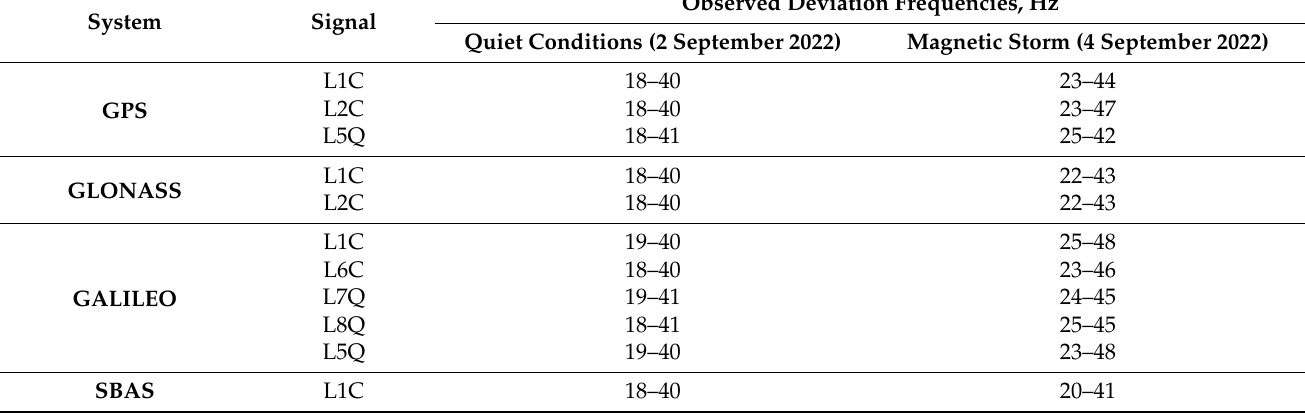
Table 4. The observed deviation frequencies obtained from GNSS signals at 100 Hz by Septentrio